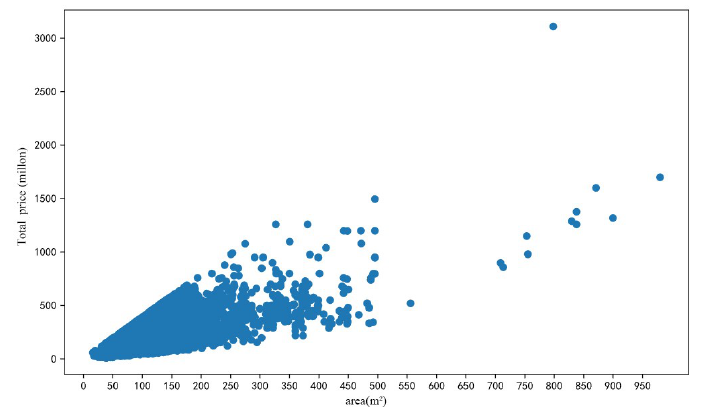
Fig. 13 The relationship between area and total